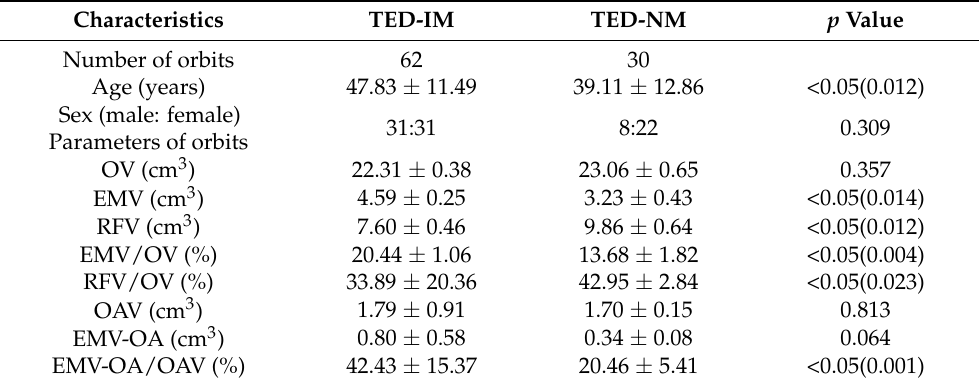
Table 1. Clinical characteristics of TED patients with impaired motility (TED-IM) and normal motility (TED-NM).